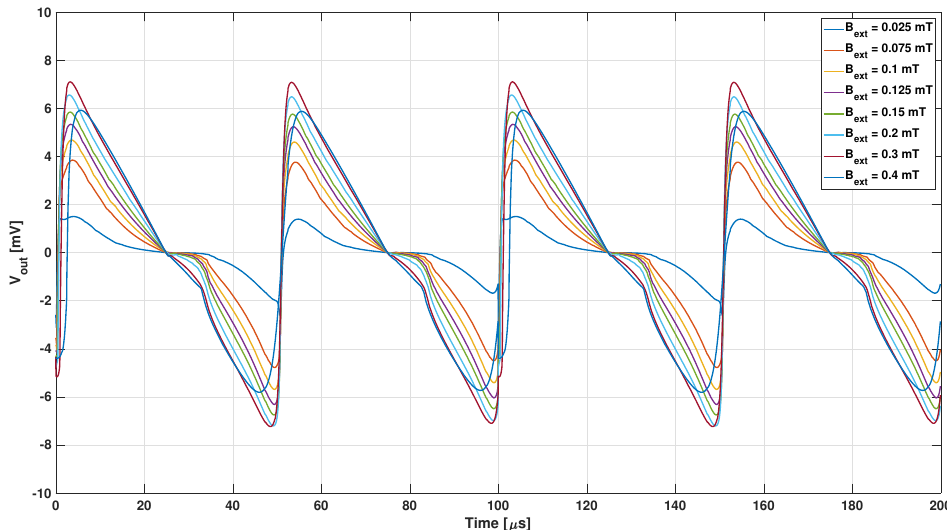
Figure 18. Output voltage obtained with the hysteretic Jiles–Atherton model with the JA2 parameters for different values of the external magnetic field.